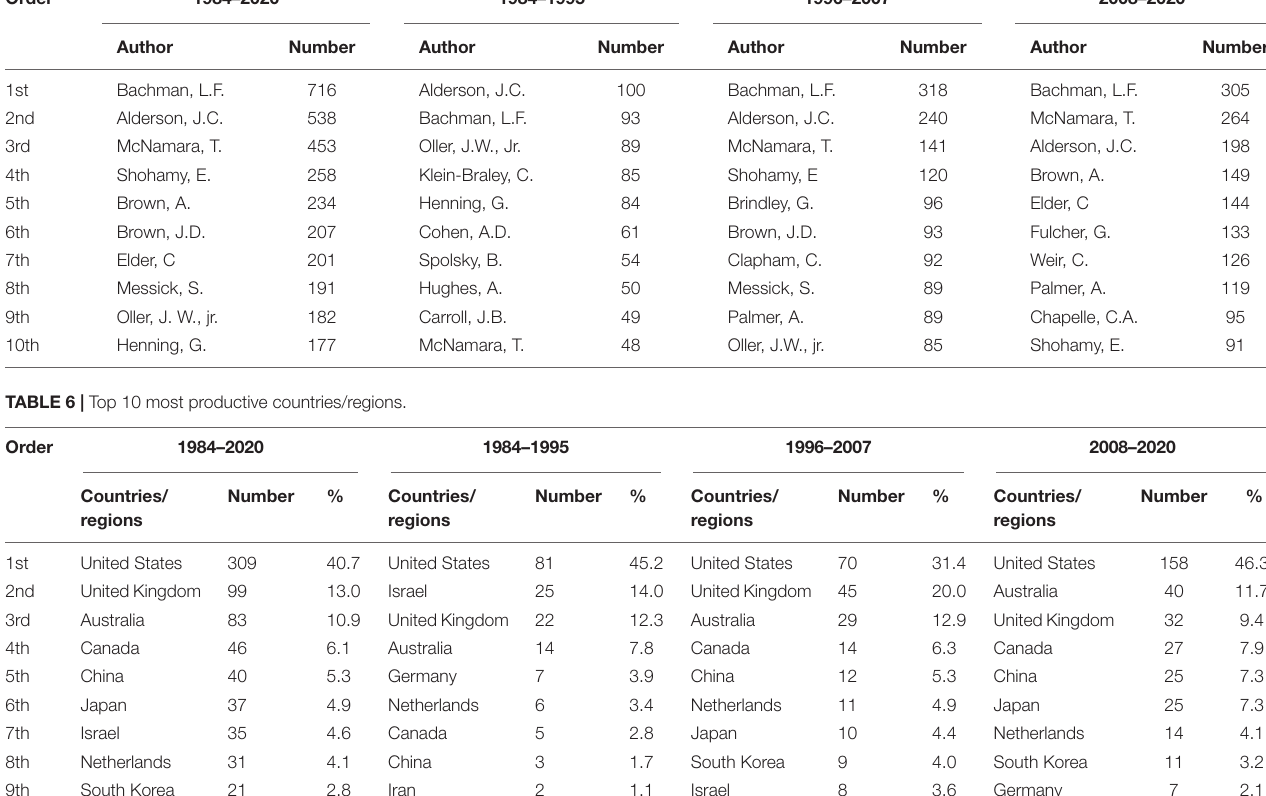
TABLE 5 | Top 10 most highly-cited authors (as measured by references). Order